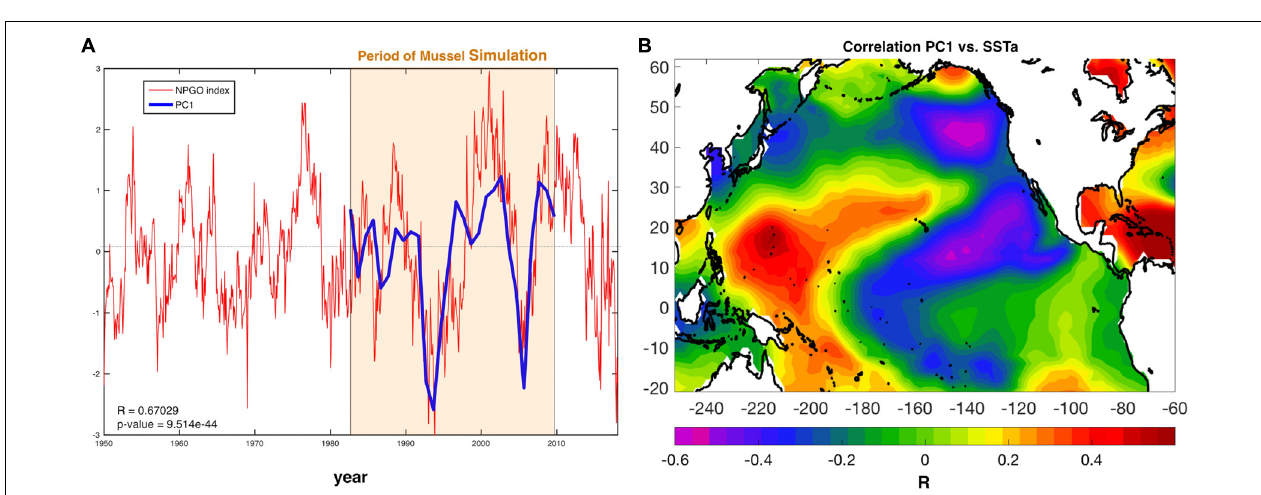
FIGURE 3 | (A) Dominant Empirical Orthogonal Function (EOF) of the annual anomalies in mussel production. The EOF1 explains 83.08% of the interannual variability. (B) The time series associated with interannual fluctuations in EOF1, also referred to as the first Principal Component (PC1). PC1 is evaluated 20 months after the date of farm initiation due to the lag of harvest with respect on the environmental data.